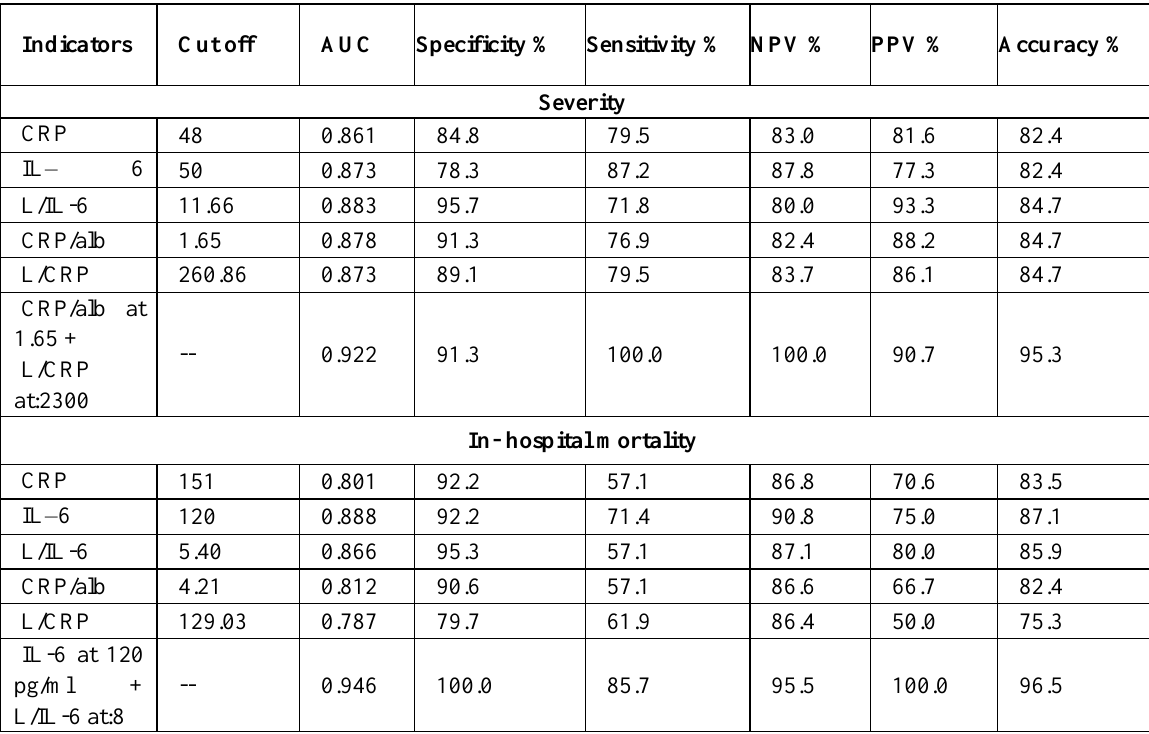
Table 3. Diagnostic validity and receiver operating curve (ROC) analysis for the ability of CRP, IL-6 and their derived indices to distinguish COVID-19 infected patients according to severity and mortality of the disease.